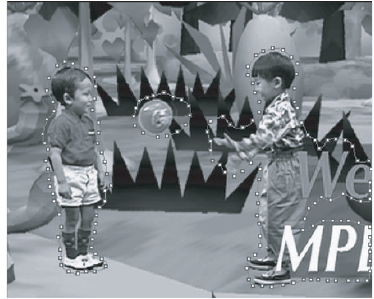
Figure 4: Spline convergence after changing topology.